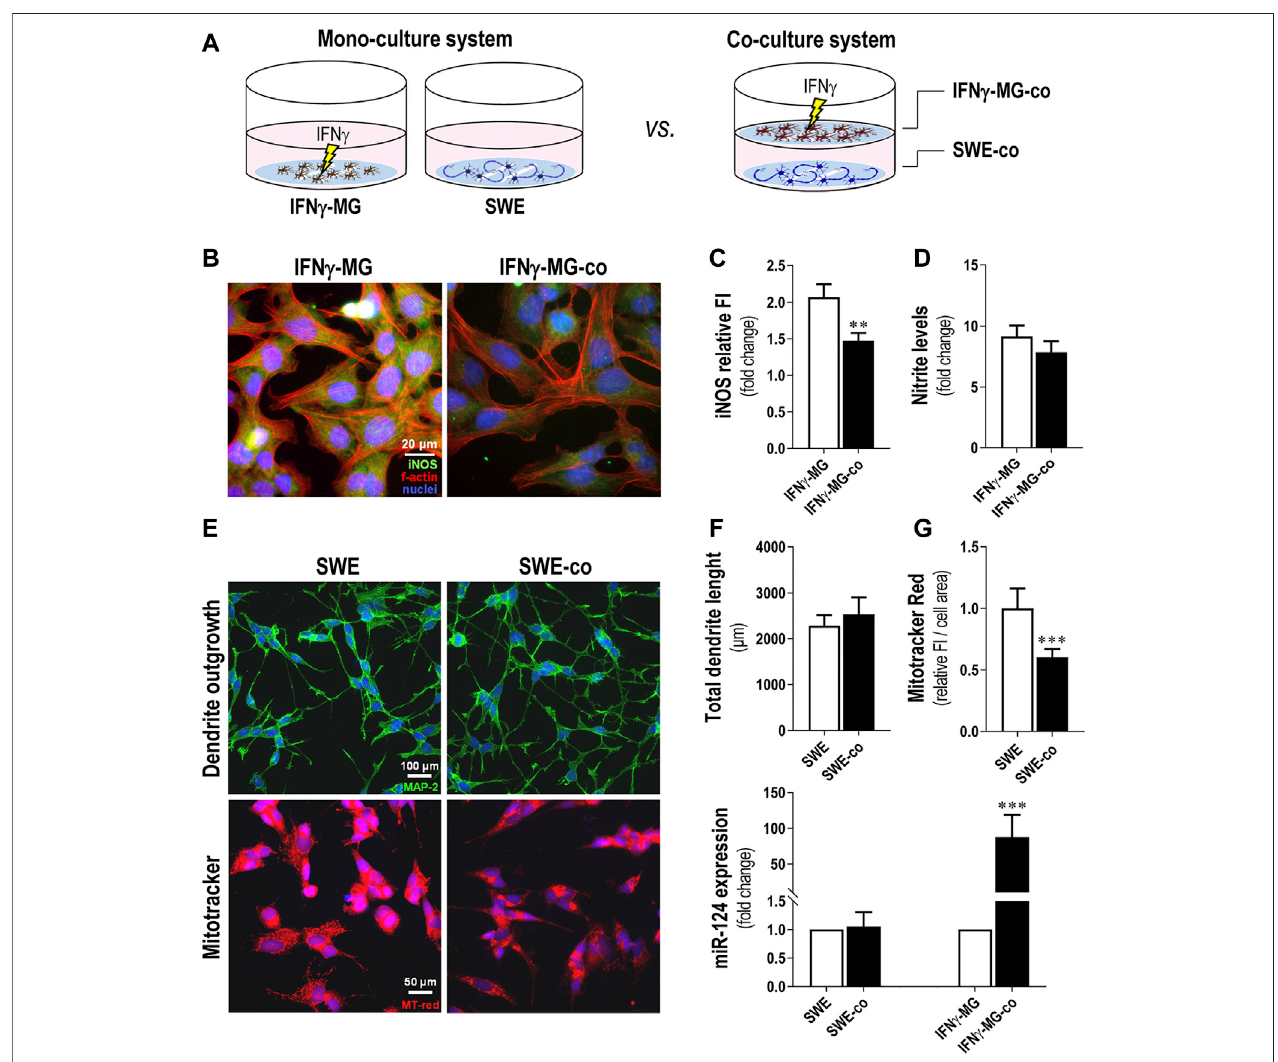
FIGURE 3 | Coculture of IFN γ -MG with SWE cells reduces neuronal MitoTracker intensity, while increasing microglial iNOS immunostaining and miR-124 expression levels. SWE cells were differentiated using 10 µM retinoic acid for 7 days before experiments, and CHME3 microglia were pretreated with IFN- γ for 24 h beforecoculture,asdetailedinthe MaterialsandMethods section. (A) Schematicrepresentationofthecocultureestablishment. (B) Representative fl uorescenceimages of iNOS (green) and f-actin (red) in MG monocultures and cocultures with SWE cells. Cell nuclei were stained with Hoechst 33258 dye (blue). (C) Comparison of MG-iNOS relative fl uorescence intensity (FI) and (D) nitrite accumulation in the cell media when in the monocultures and coculture system with the SWE cells. (E) Representative fl uorescenceimagesofMAP-2(green)andMitoTracker(red)inMGmonoculturesandcocultureswithSWEcells. (F) Comparison oftotaldendrite length and (G) MitoTracker fl uorescence intensity when in the monocultures and the coculture system with the SWE cells. (H) Comparison of the miR-124 expression levels in SWE and CHME3 cells monocultures vs . cocultures. Results are mean ± SD, obtained from at least three independent experiments. ** p < 0.01 and *** p < 0.001 vs . respective monocultured cells, two-tailed Student ’ s t -test. MG, CHME3 human microglia cells; IFN γ -MG, IFN γ -stimulated CHME3 human microglia cells; SWE, human SH-SY5Y cells expressing the APP695 Swedish mutant protein; co, cocultures; iNOS, inducible nitric oxide synthase; miR, miRNA.